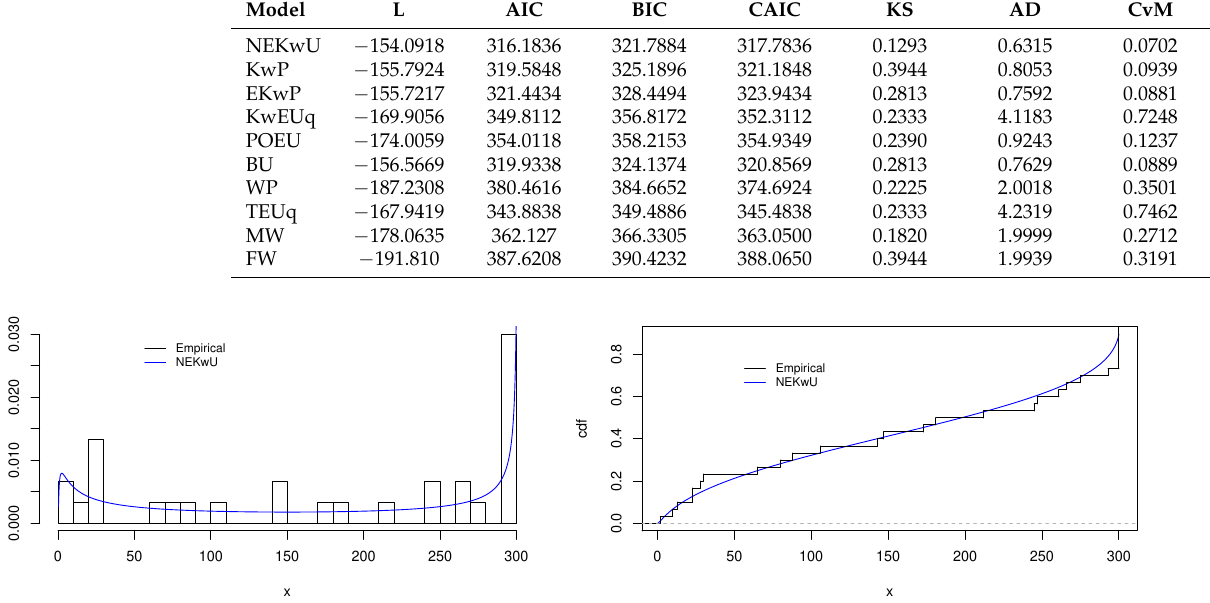
Figure 4. Plots of the histogram with ( left ) the fitted pdf and ( right ) fitted cdf of the NEKwU model for the first data set.